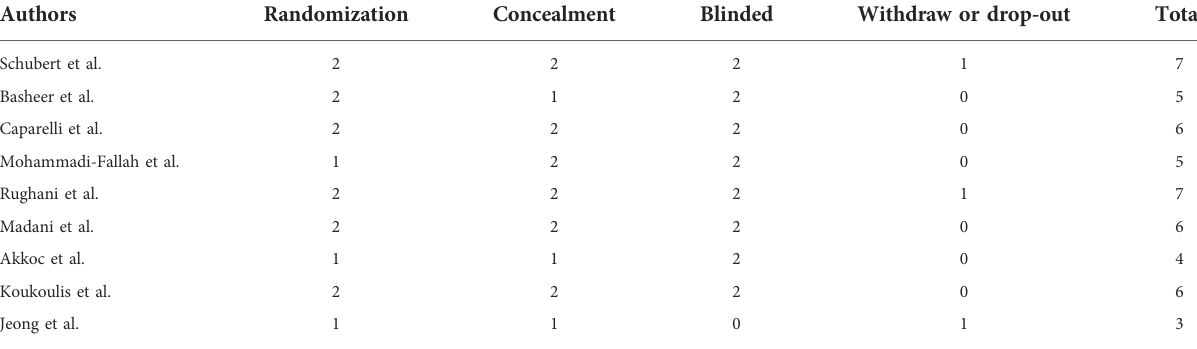
TABLE 3 Details of Jadad